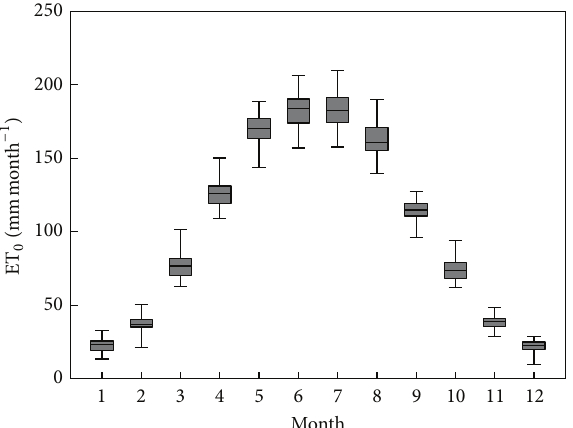
Figure 4: Box and whisker plots of monthly ET 0 of the HRB from 1961 to 2014. The line inside the boxes represents the median, and the upper and lower lines of the boxes indicate the 75th and 25th percentiles, respectively. The upper and lower parts of the whiskers indicate the maximum and the minimum of monthly ET 0 ,